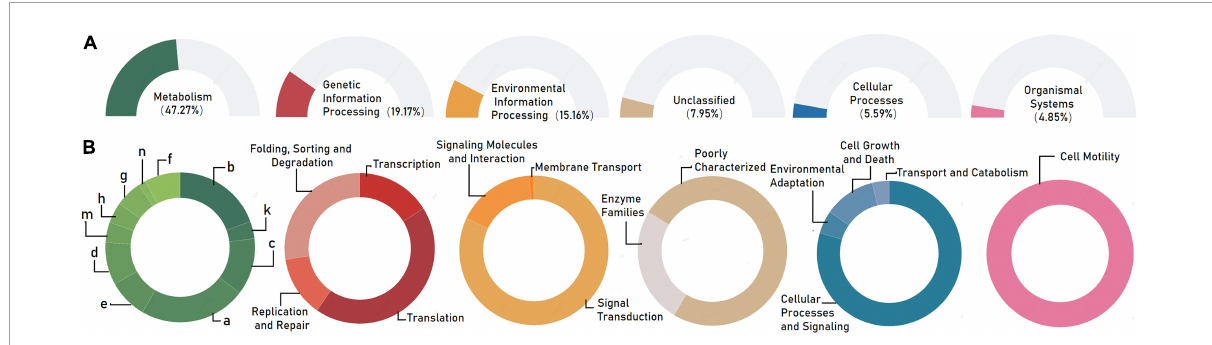
FIGURE3 Functional prediction of the whole bacterial microbiome associated with Karlodinium veneficum in KEGG categories at level 1 (A) and level 2 (B) . Gene functions were predicted from 16S rRNA gene-based microbial compositions using the PICRUSt algorithm to make inferences from KEGG annotated databases. Relative signal intensity was normalized by the number of the genes for each indicated metabolic pathway. a: amino acid metabolism; b: carbohydrate metabolism; c: energy metabolism; d: metabolism of cofactors and vitamins; e: lipid metabolism; f: nucleotide metabolism; g: xenobiotics biodegradation and metabolism; h: glycan biosynthesis and metabolism; m: metabolism of terpenoids and polyketides; n: biosynthesis of other secondary metabolites.